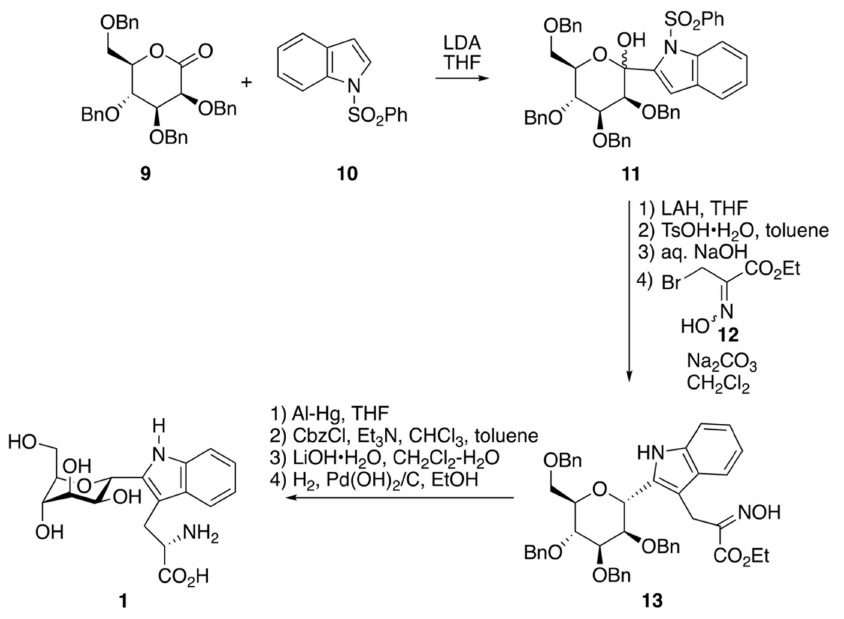
Scheme 2. Synthesis of C -Man-Trp from mannose